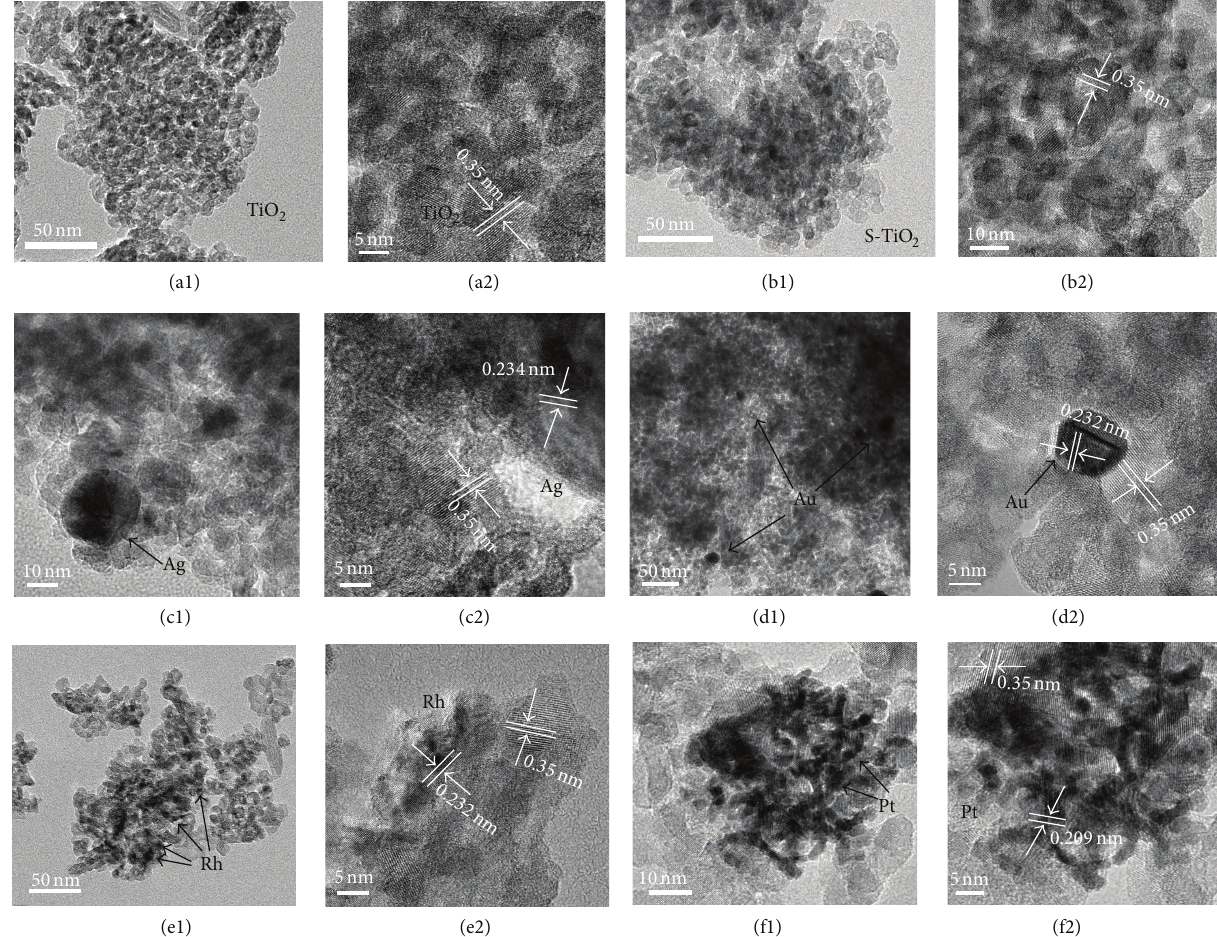
Figure 3: TEM and HRTEM images of TiO 2 (a1, a2), SO 42− /TiO 2 (b1, b2), SO 42− /Ag-TiO 2 (c1, c2), SO 42− /Au-TiO 2 (d1, d2), SO 42− /Rh-TiO 2 (e1, e2), and SO 42− /Pt-TiO 2 (f1, f2)